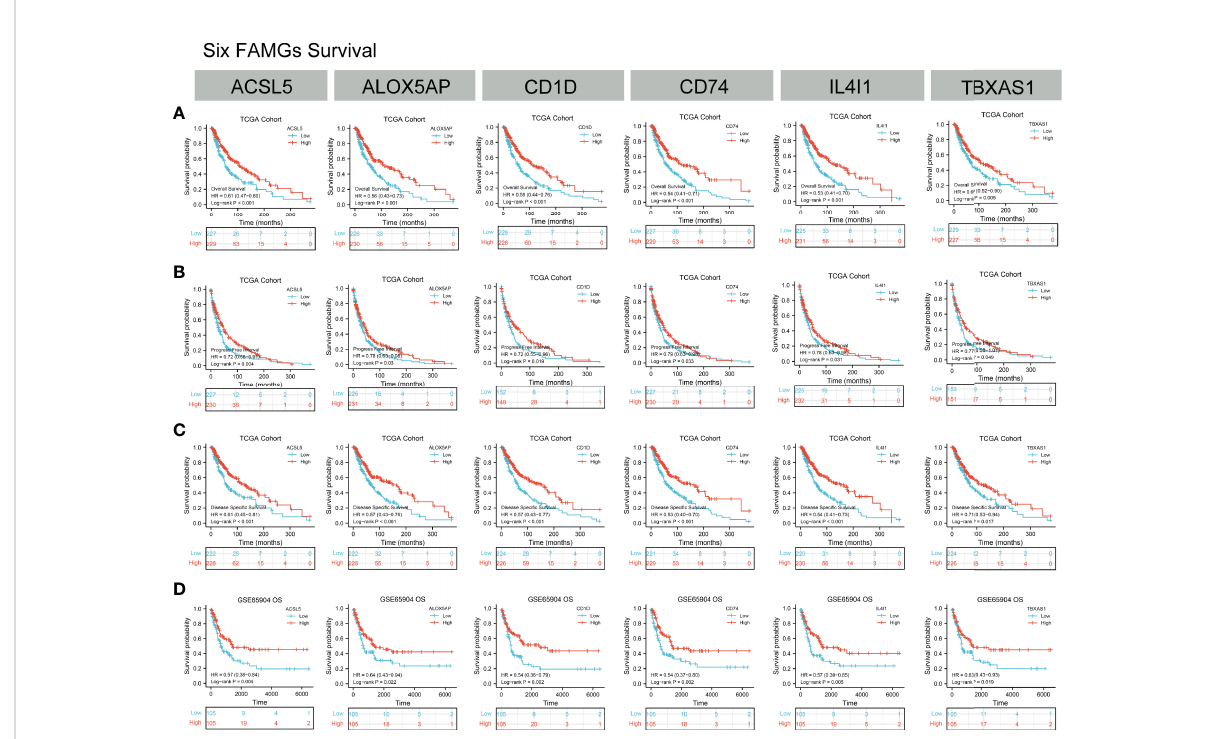
FIGURE 6 Kaplan-Meier analyses. (A – C) OS, PFS and DSS according to ACSL5, ALOX5AP, CD1D, CD74, IL4I1 , and TBXAS1 expression status in TCGA samples. (D) OS, PFS, and DSS according to ACSL5, ALOX5AP, CD1D, CD74, IL4I1 , and TBXAS1 expression status in GEO samples. K-M results showed the high-expression of ACSL5, ALOX5AP, CD1D, CD74, IL4I1 , and TBXAS1 had a better prognosis in CM patients.